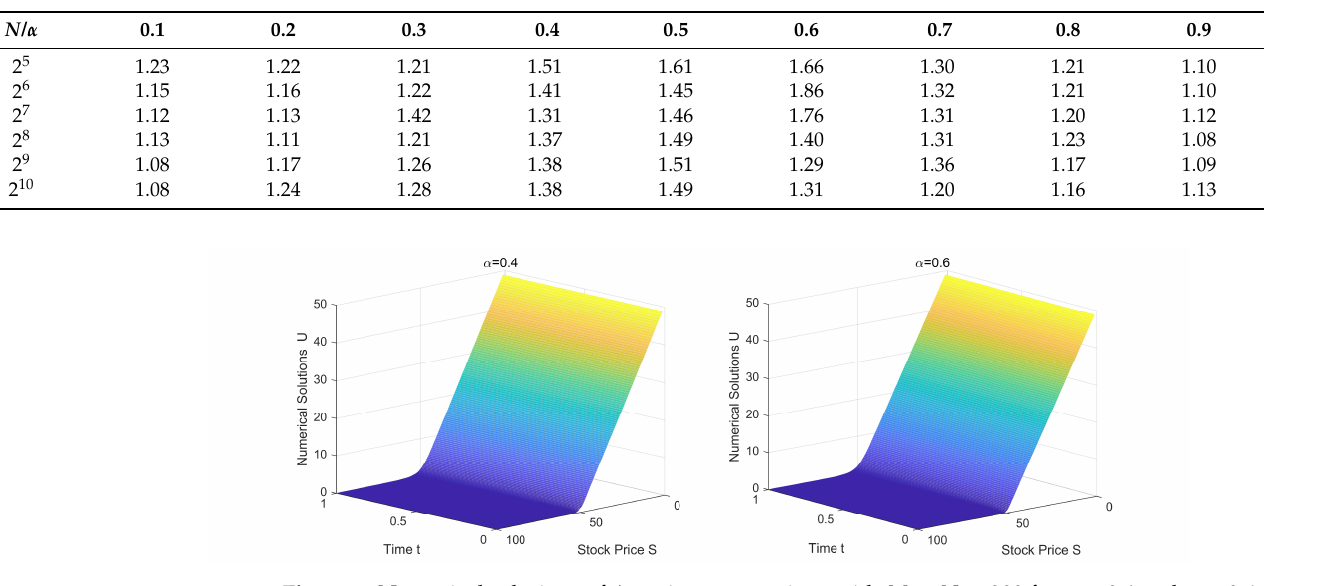
Figure 3. Numerical solutions of American put options with M = N = 200 for α = 0.4 and α = 0.6.